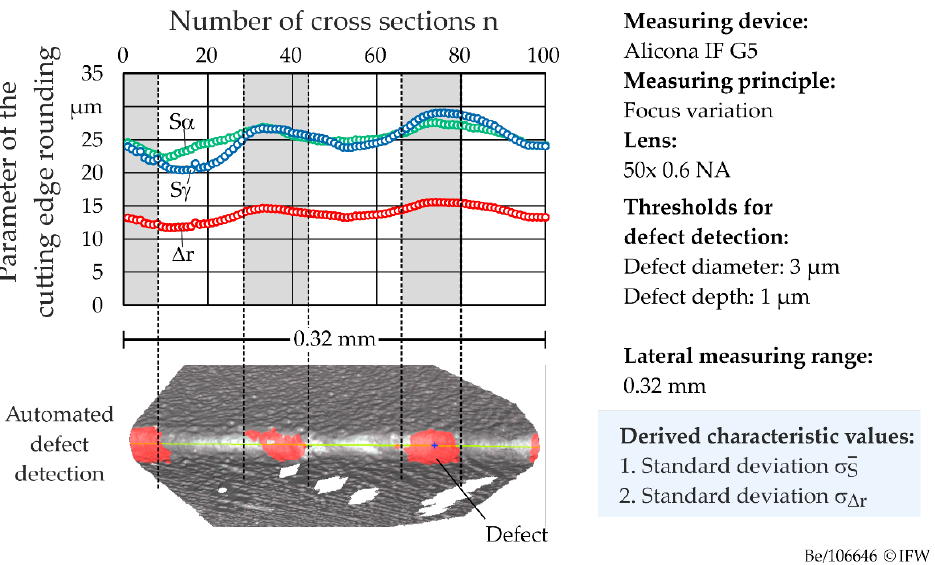
Figure 11. Correlation between the parameters characterizing cutting edge rounding and the defective areas along the cutting edge.